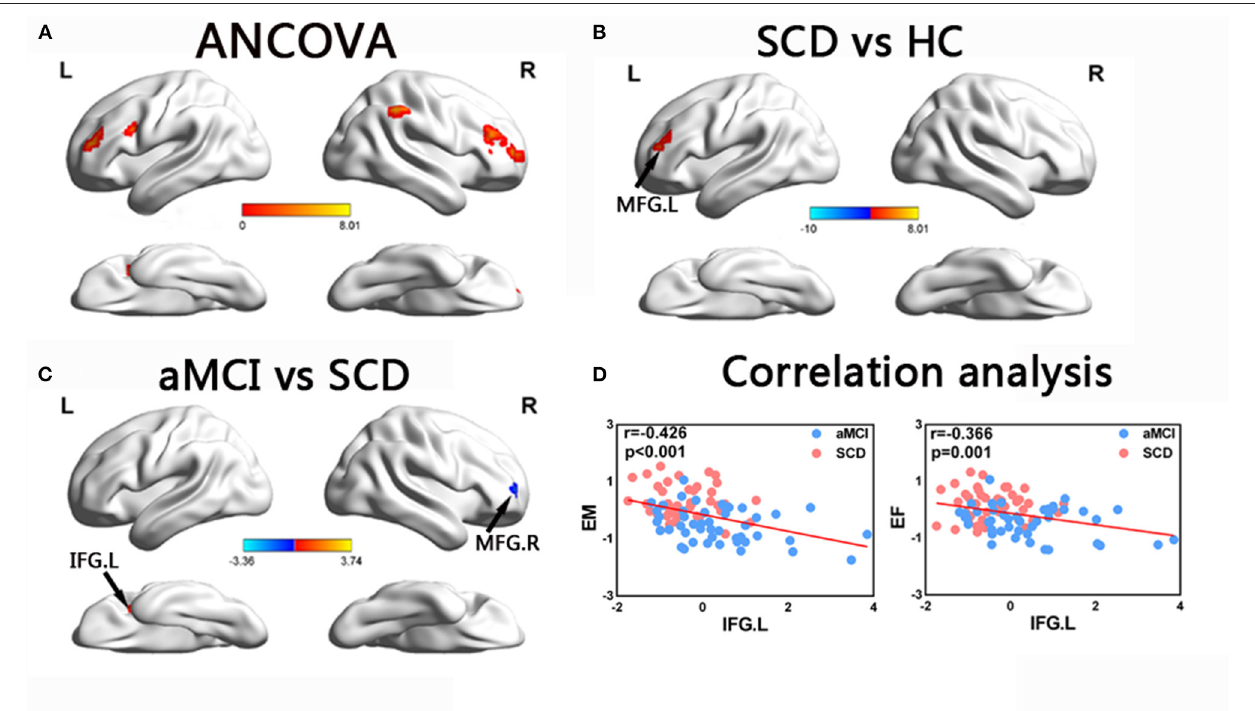
FIGURE 4 | Brain regions exhibiting significant differences in dynamic functional connectivity variability within executive control network and the correlation with cognitive function. (A) Brain regions showing significant differences in dynamic functional connectivity variability within the executive control network across three groups, including SCD, aMCI, and HC ( p < 0.05, the cluster size > 19 voxels). (B,C) Results of post hoc analysis in voxel-wise analysis (TFCE-FWE corrected, cluster size > 9, p < 0.05). (D) Results of associations between altered dynamic functional connectivity variability and cognitive function. Age, gender, and years of education were used as covariates of results (Bonferroni corrected, p < 0.05). aDMN, anterior default mode network; pDMN, posterior default mode network; aMCI, amnestic mild cognitive impairment; SCD, subjective cognitive decline; HC, healthy controls; MFG, middle frontal gyrus; IFG, inferior frontal gyrus; EM, episodic memory; EF, executive function; R, right; L,